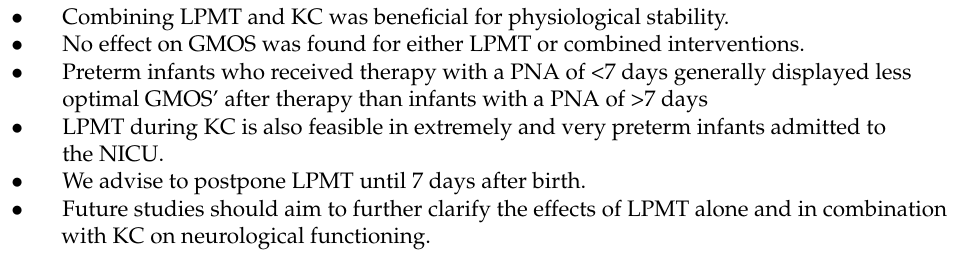
Table 3. Key points of this